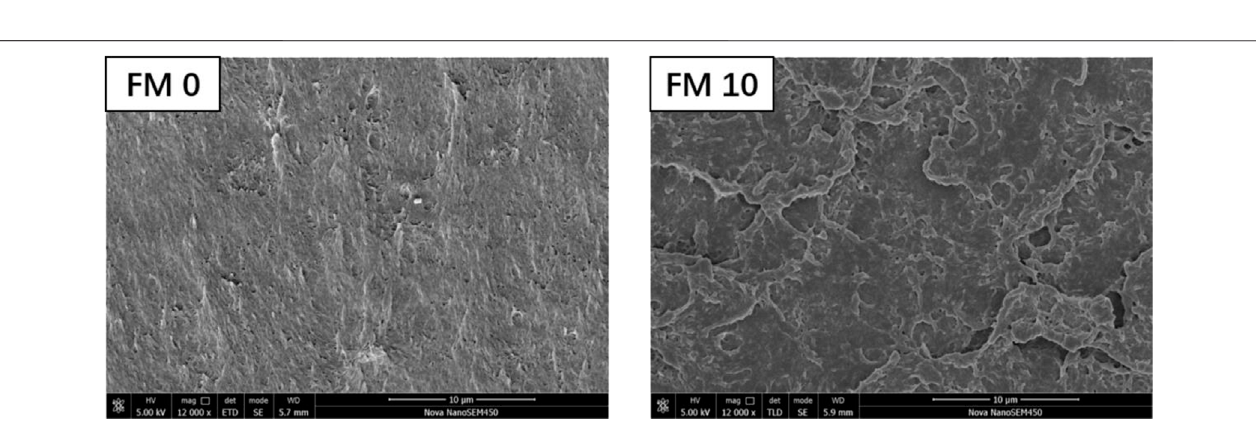
FIGURE 2 | Morphology of neat PCTFE (FM0) and PCTFE/FCO blends (FM10).